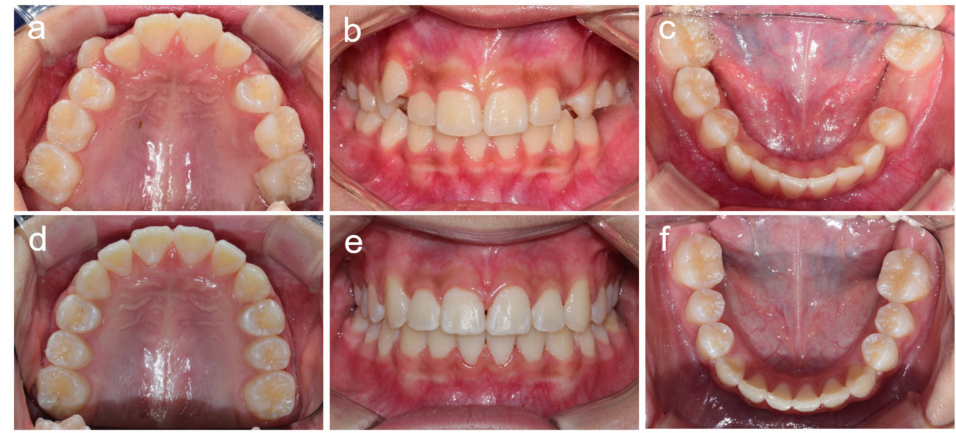
Figure 9. Clinical photos of patient 5. ( a – c ) Clinical photos at age 11 years 2 months. ( d – f ) Clinical photos at age 13 years 2